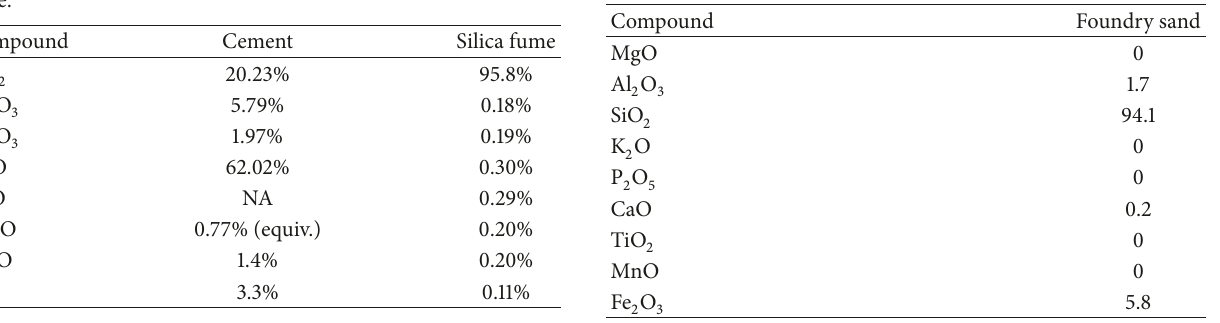
Table 2: Mineral composition of foundry sand.